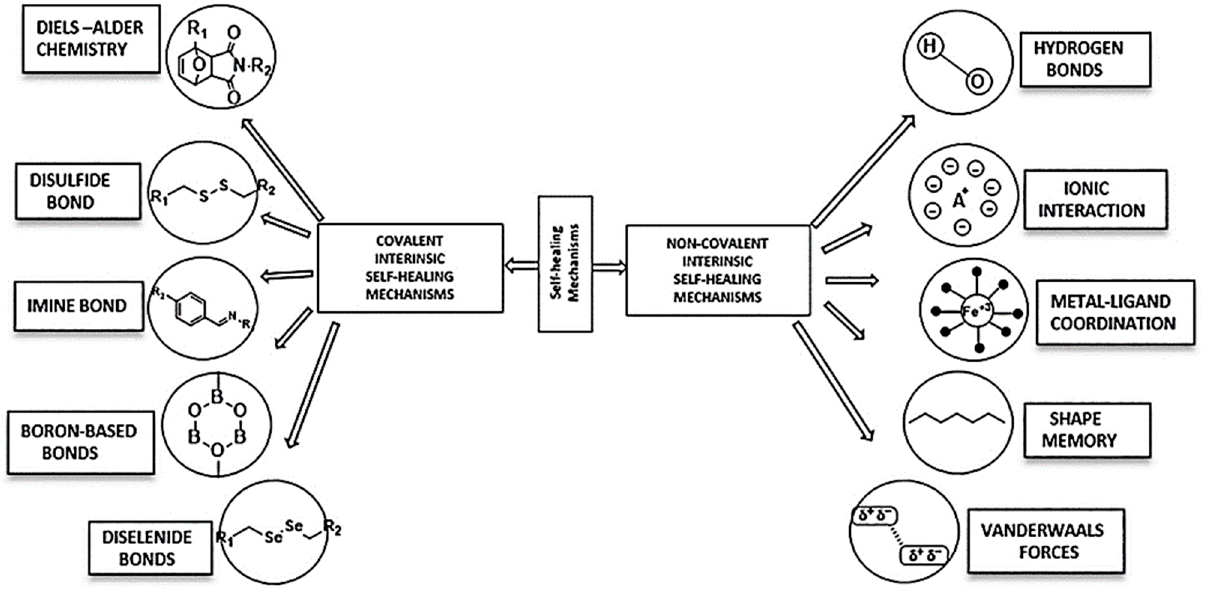
Figure 18. Covalent and non-covalent intrinsic mechanisms. Reprinted with permission from [165]. 2022, Wiley.